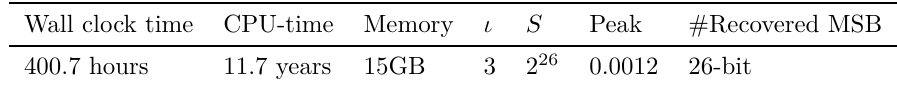
Table 4: Implementation results of the attack against qDSA signatures with nonces of 2-bit bias